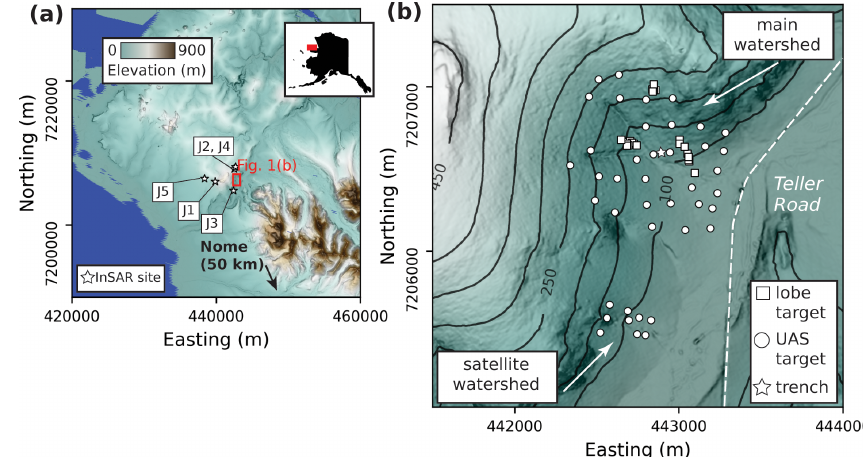
Figure 1. Overview of regional setting (a) , with location within Alaska, and site (b) . Star symbols in (a) indicate locations of InSAR-derived displacement observations. In (b) , squares denote differential GPS survey targets for lobe features, and circles denote targets for uncrewed aerial survey (UAS) calibration points. Star is location of deep ( > 1m) trench. Location of Teller Road is shown as a white dashed line. Contour lines are 50m intervals for elevation data. Elevation data are meters above sea level derived from ArcticDEM. Northing and easting coordinates UTM zone